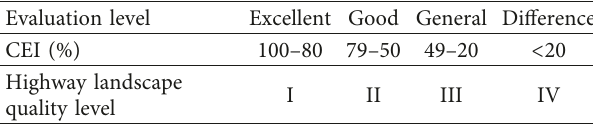
Table 3: The values of evaluation